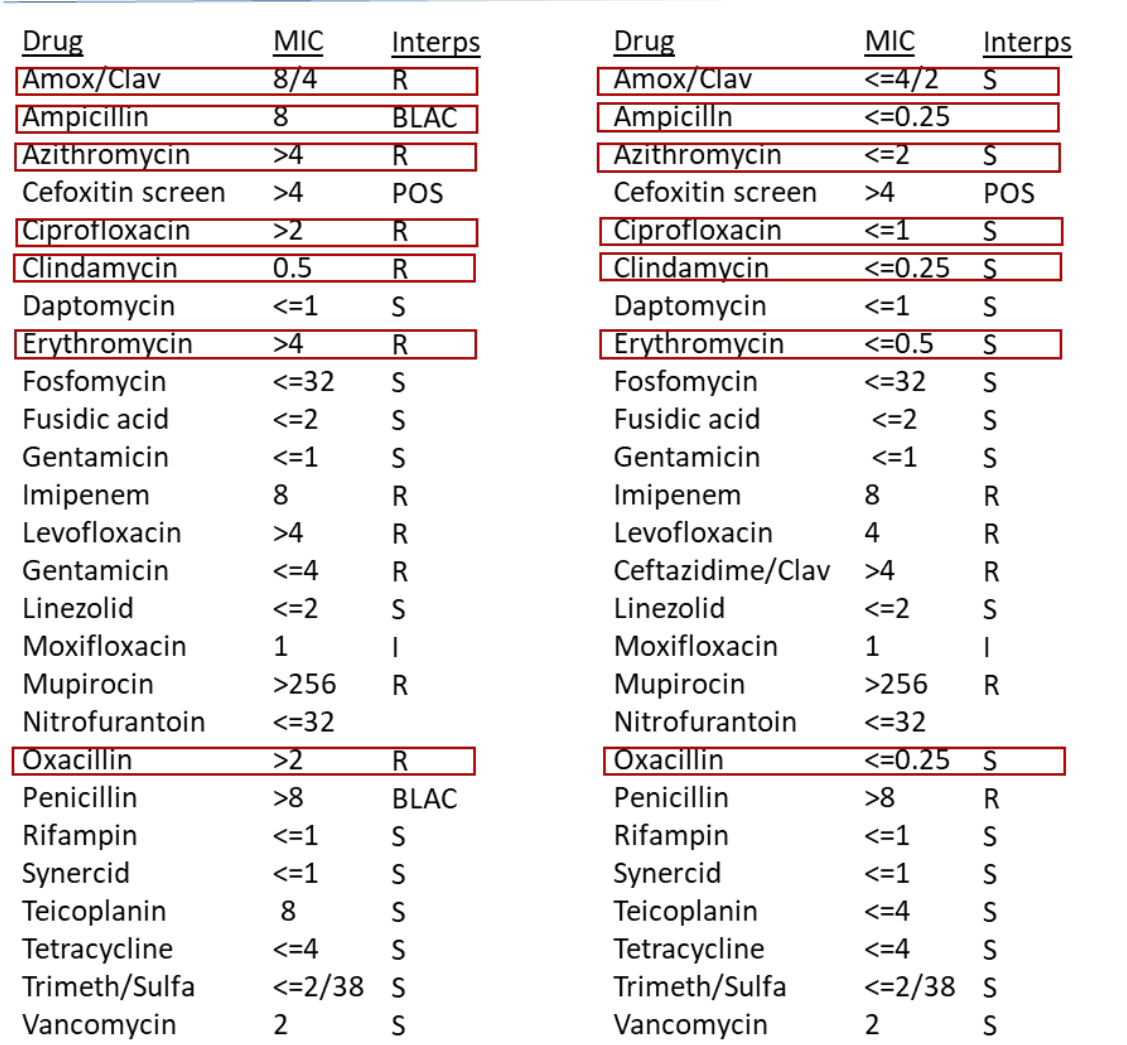
Figure 7. Demonstration of effect of bovine lactoferrin (bLF) on Methicillin resistant Staphylococcus epidermidis